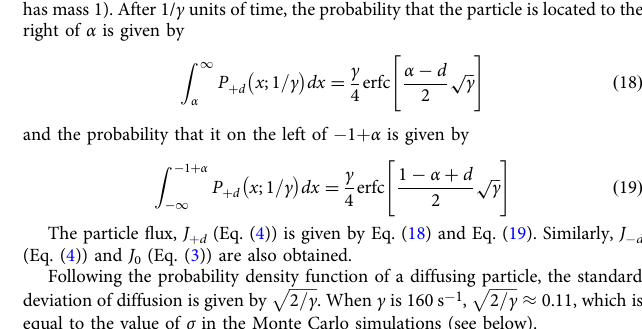
(cid:6) 0.11, which is